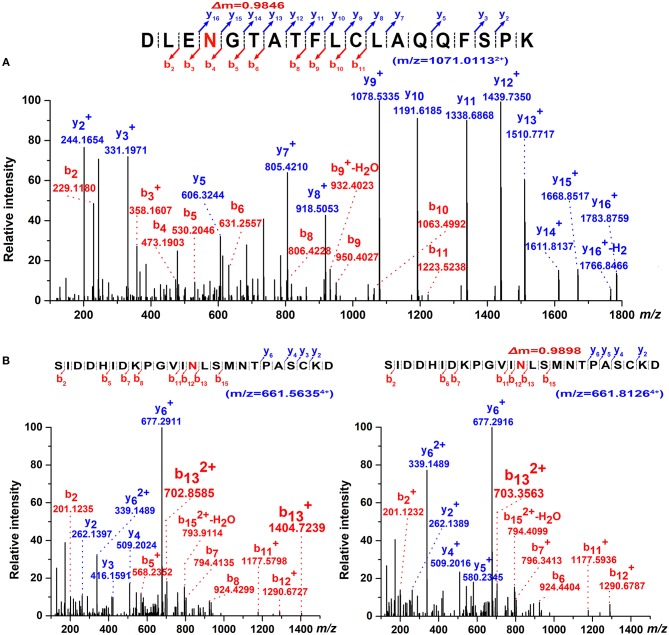
Determination of N-glycosylation sites by high-resolution ESI MS. (A) Representative MS/MS spectrum of the tryptic 259D–277Kpeptide (m/z = 1071.01132+) covering Asn-262 glycosite with PNGase F digestion. The mass increment of 0.9846 Da comparing to its theoretical mass weight is indicated. (B) Dimer-isotopic mass spectrum of 553S–576D peptide covering Asn-565 glycosite. Non-glycosylated 553S–576D peptide (m/z = 661.56354+) is shown in left panel, while de-glycosylated 553S–576D peptide (m/z = 661.81264+) with a mass increasing of 0.9898 Da due to the converting of Asn-565 residue to an Asp with PNGase F treatment is indicated in right panel.